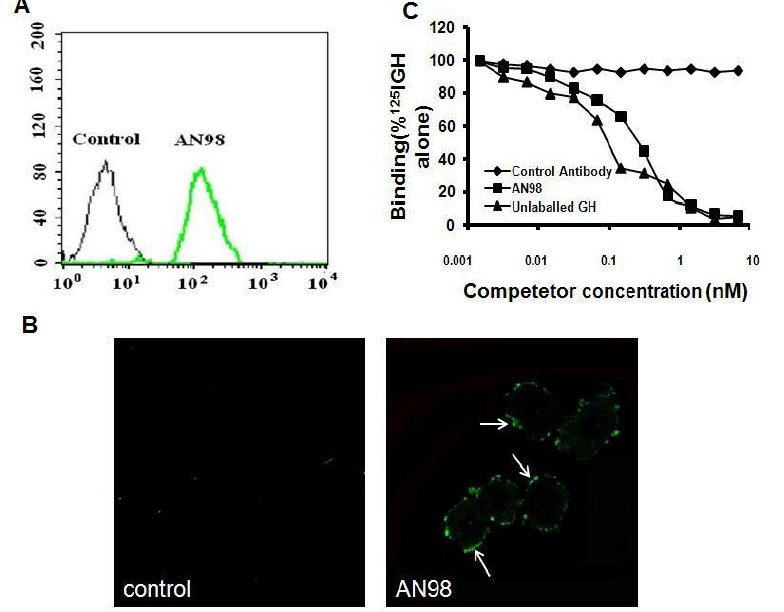
Figure 2. AN98 recognized full-length GHR. CHO-pGHR cells or hepatocytes were pre-treated as described in the materials and methods. (A) FACS analysis. CHO-pGHR cells were incubated with AN98 or an isotype control for 0.5 h at 4°C. The cells were incubated with an FITC-conjugated secondary antibody. Labelled cells were analysed by a FACSCalibur flow cytometry device (Becton Dickenson, Franklin, NJ, USA). Data were analysed using Cell Quest software. (B) IFA analysis. Porcine hepatocytes were incubated with AN98 or an isotype control monoclonal antibody for 0.5 h at 37°C. Cells were then incubated with FITC-labelled goat anti-mouse IgG secondary antibody for 0.5 h at 37°C in the dark. Cells were analysed with a confocal laser scanning microscopy (Olympus FV1000, Tokyo, Japan). (C) Competitive receptor-binding assays. CHO-pGHR cells were incubated with FITC-pGH and different concentrations of unlabelled pGH, AN98, or an isotype control for 1 h in the dark at 4°C. After three washes with PBS, the labelled cells were analysed on a FACSCalibur Flow Cytometer (Becton Dickenson, USA). Data were analysed using Cell Quest software. GHR, growth hormone receptor; FACS, fluorescence activated cell sorter; FITC, fluorescein isothiocyanate; IFA, immunoinfluscent assay; PBS, phosphate buffer